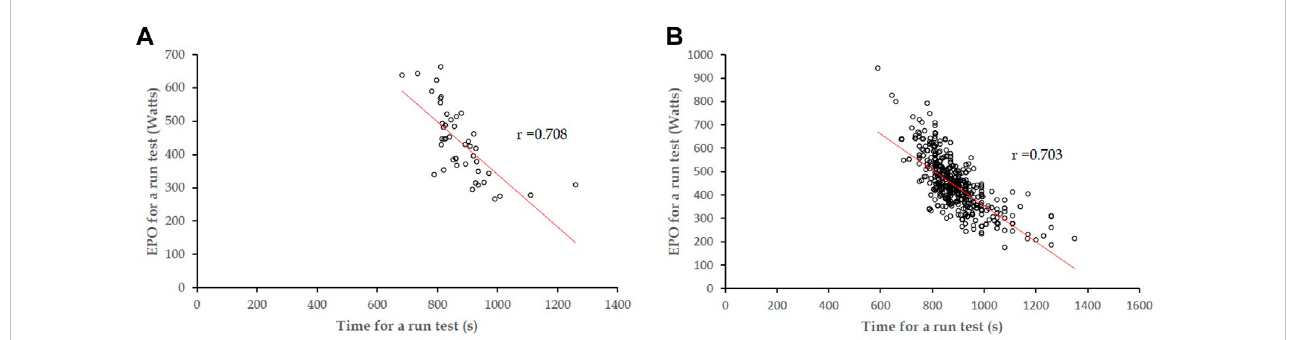
FIGURE 1 (A) Correlationcoef fi cient(r)oftimeagainstEPOfora3,000-mrun fi eldtest,estimatedtobe0.708( p < 0.001)inparticipantsforbotha3,000-mrun fi eld test and CPET. (B) Correlation coef fi cient estimated to be 0.703 ( p < 0.001) in the variable-matched participants for a 3,000-m run fi eld